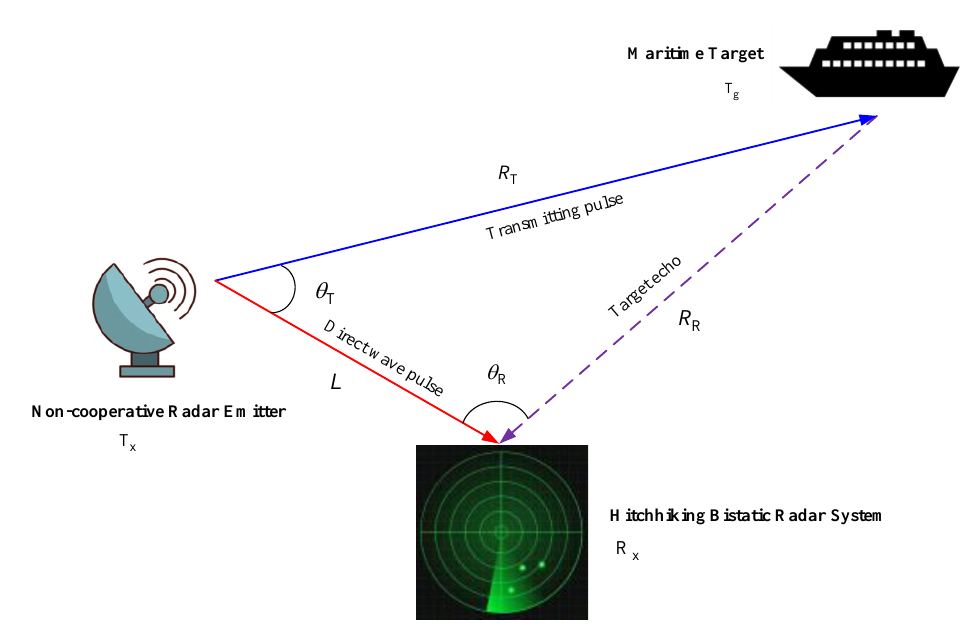
Figure 2. Geometrical relationship of HBR system.